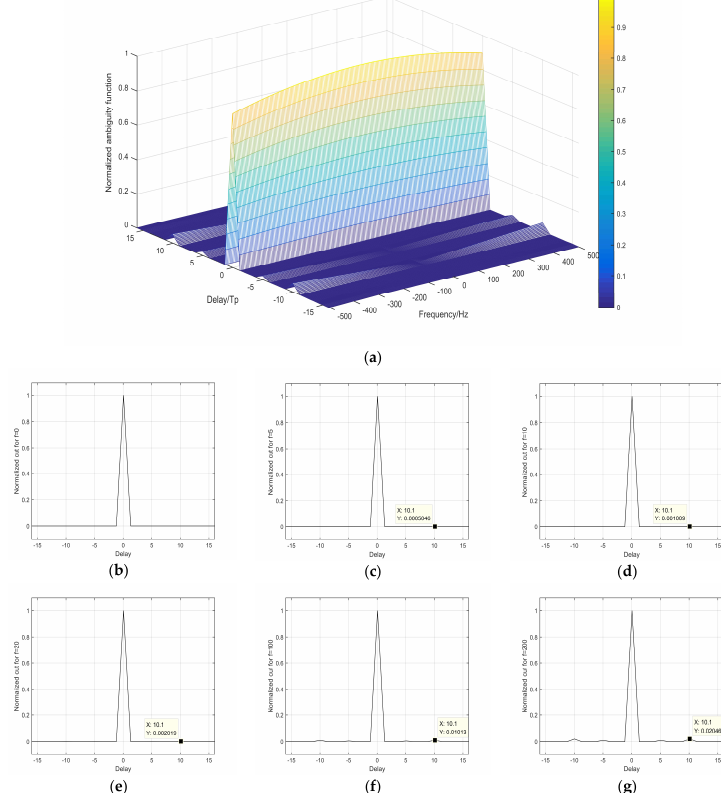
Figure 4. Normalized Ambiguity Function Analysis of Complete Complementary Code: ( a ) Normalized ambiguity function; Normalized ambiguity cut for ( b ) f = 0, ( c ) f = 5, ( d ) f = 10, ( e ) f = 20, ( f ) f = 100, ( g ) f = 200.